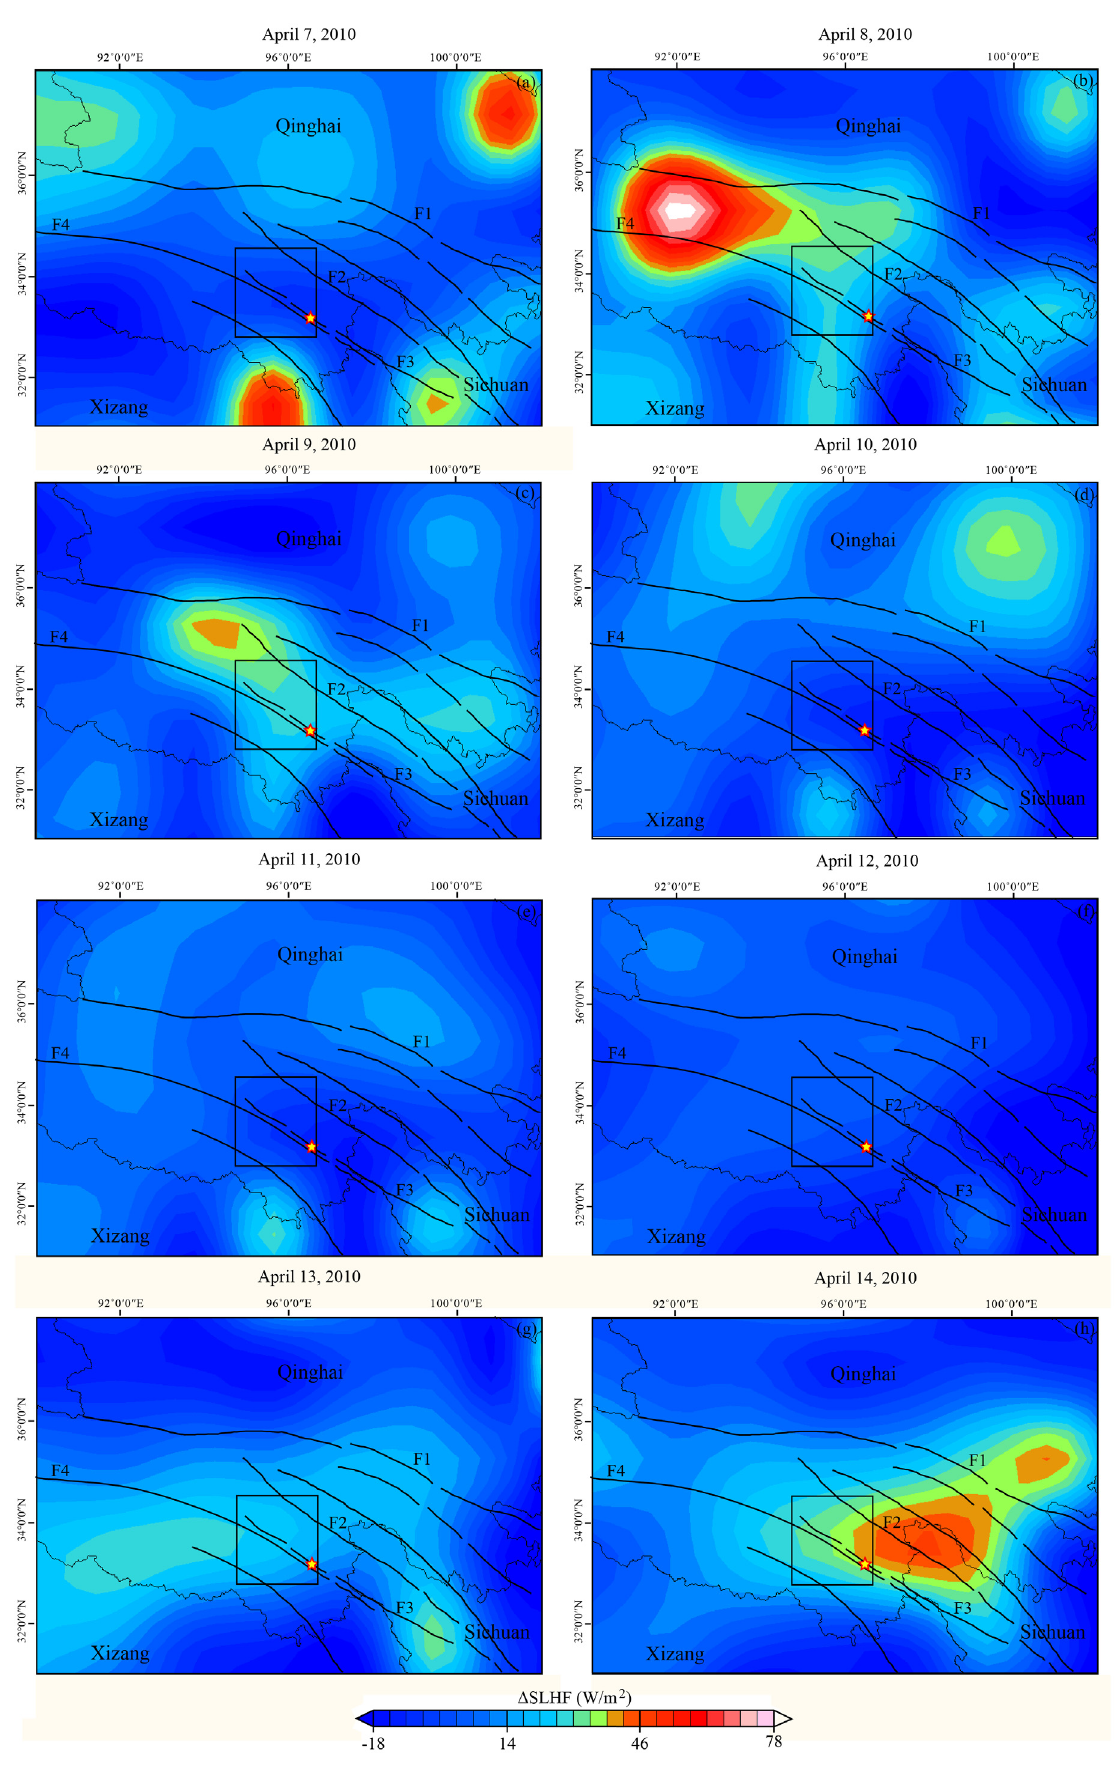
Figure 4. The SLHF difference images of the daily mean in the Yushu region from April 7 to 14, 2010. The yellow stars indicate the epicen- ter. The black rectangular boxes indicate the epicenter pixel (33.36°N,